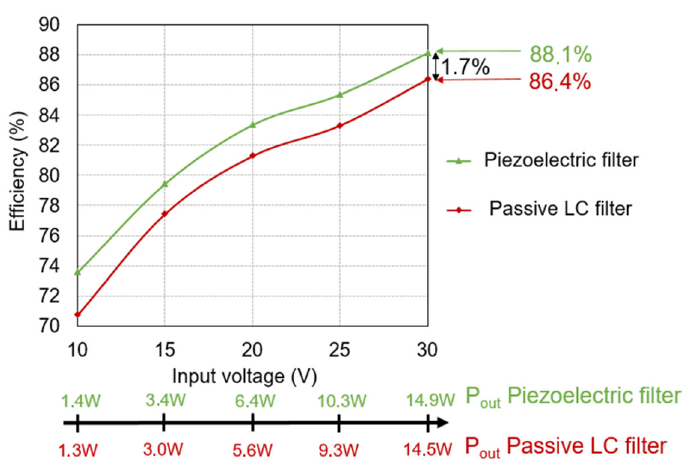
Figure 12. Comparison of the measured efficiency of the L − Piezo inverter with a piezoelectric filter and a passive LC filter for several input voltage values.